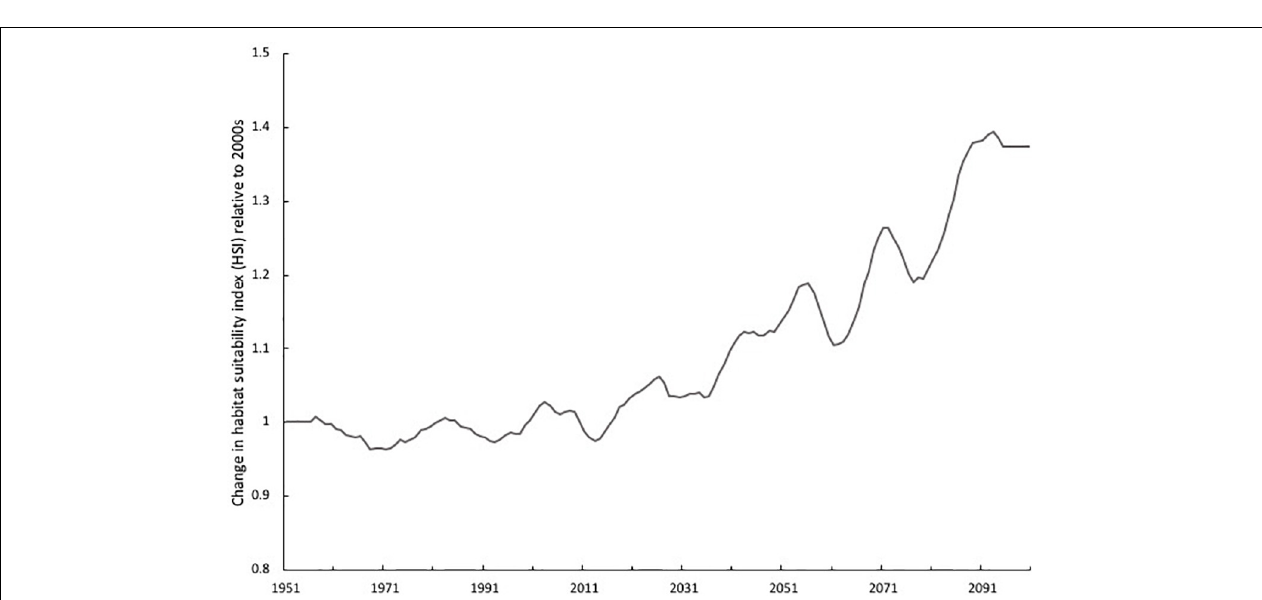
FIGURE 6 | Results from the DBEM-EDM model on the change in Habitat Suitability Index (HSI) in Norwegian EEZ.